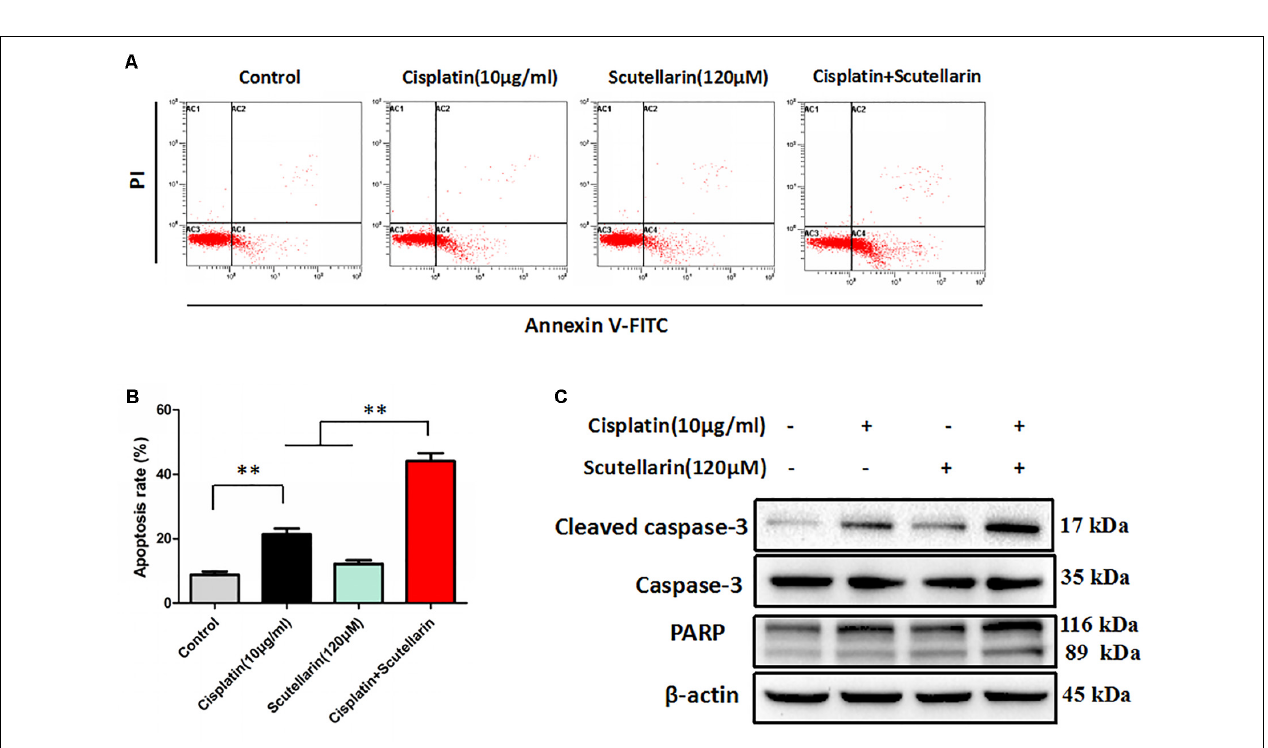
FIGURE 2 | Scutellarin enhanced cisplatin-induced apoptosis. (A) Cells were exposed to cisplatin with or without scutellarin for 48 h, cell apoptosis was measured by flow cytometric analysis. (B) Apoptosis rate in each group. (C) Western blot analysis showing caspase-3, cleaved caspase-3 and PARP expression levels in A549/DDP cells treated as indicated. Actin was used as loading control. Data are representative of three independent experiments (mean ± SEM). ∗∗ p < 0.01.